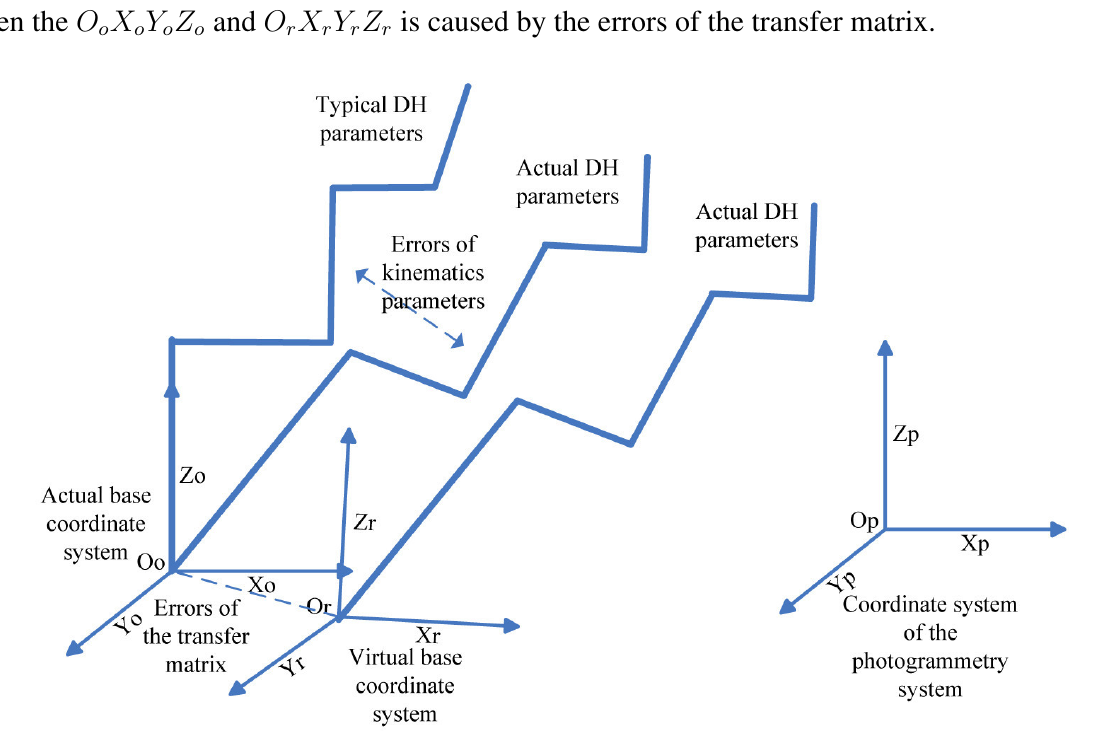
Figure 5. Simplified model of the robot